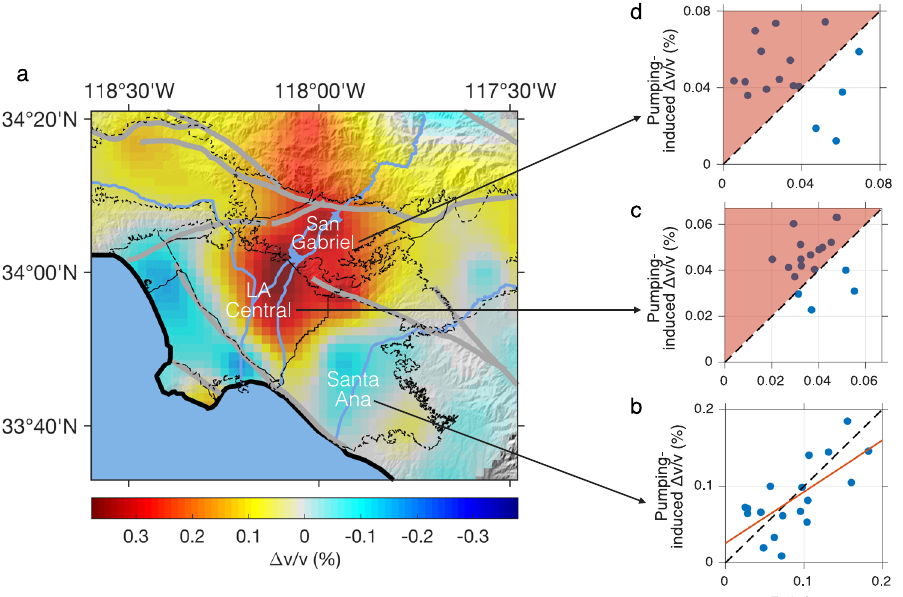
Fig.4|Long-term Δ v/v indifferentgroundwaterbasins.a Mapshowingthe Δ v/v accumulatedfrom2000to2020(measuredin0.2 – 0.8Hz).Coldercolorsassociate with cumulative increases in groundwater and warmer colors with cumulative declines. Note that the boundary between the Santa Ana Basin and the LA Central Basin is a municipal border (i.e., the county line between LA and Orange counties) rather than a natural hydraulic barrier. See Supplementary Fig. 4 for the accumu- lated Δ v/v in 0.5 – 2.0Hz (corresponding to shallower depth.) b – d Relationships